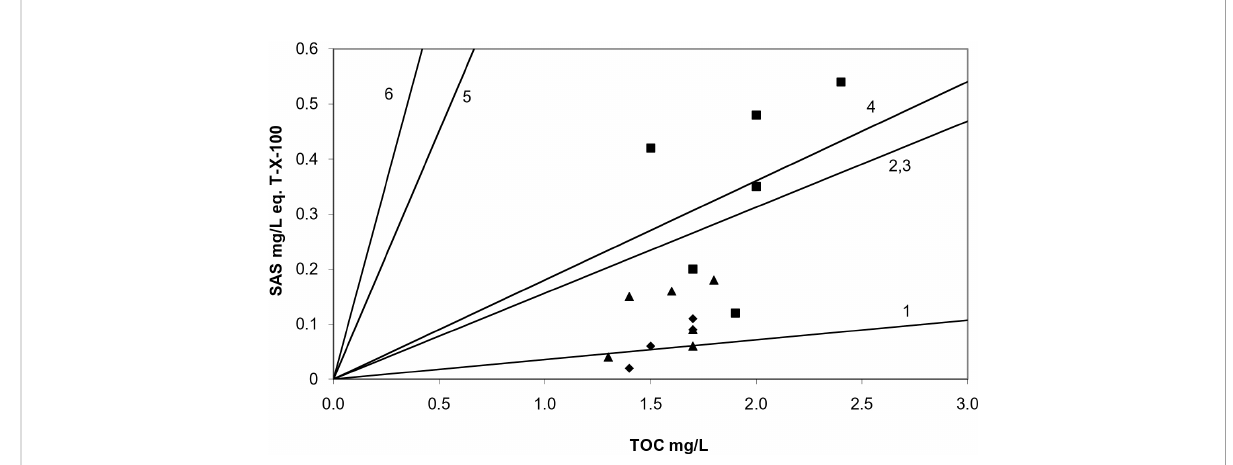
FIGURE 4 Correlation of SAS and TOC concentrations obtained in SML ( □ ), SSW 0.2 ( ○ ), and SSW 2 ( ◊ ) seawater samples. Lines correspond to different model substances: no. 1 microbial polysaccharide xanthan, no. 2 protein (Albumin), no. 3 fulvic acid, no. 4 polysaccharide dextran T-500, no. 5 Triton-X-100, and no. 6 oleic acid. SML, surface microlayer; SSW 02 , subsurface water at 0.2-m depth; SSW 2 , subsurface water at